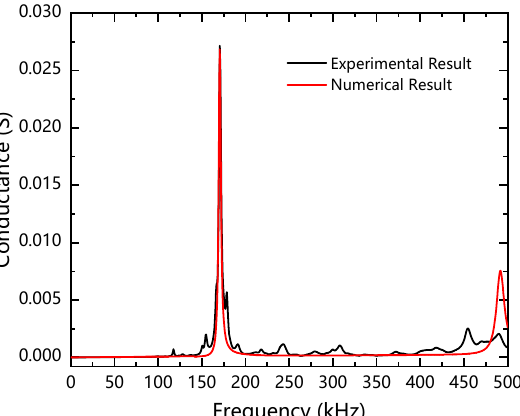
Figure 2. Experimental and numerical conductance signatures of a free PZT sensor over the sweeping frequency range 0~500 kHz.